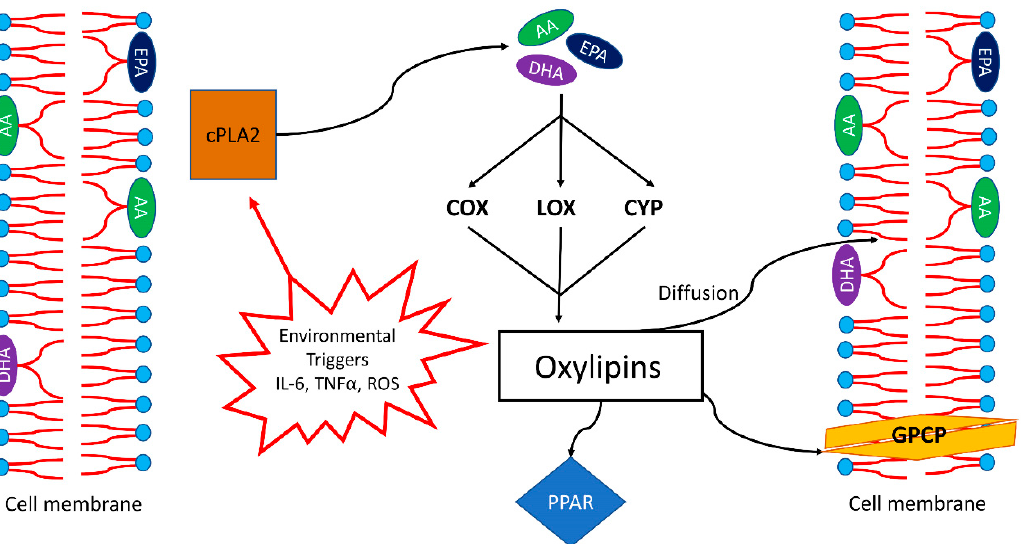
Figure 2. Formation of oxylipins from PUFAs in the membrane. In inflammation, reactive oxygen species (ROS) activate cytosolic phospholipase A2 (cPLA2), releasing PUFAs from the cell membrane. PUFAs are rapidly oxidized by COX, LOX, and CYP enzymes to form bioactive oxylipins. Oxylipins exert effects by diffusion, binding to membrane receptors (e.g., G-protein-coupled receptors (GPCP), and binding to peroxisome proliferator-activated receptors (PPARs) in the nucleus and cytosol. AA, arachidonic acid; EPA, eicosapentaenoic acid; DHA, docosahexaenoic acid; IL-6, interleukin 6; TNF α , tumor necrosis factor alpha; COX, cyclooxygenase; LOX, lipoxygenase; CYP, cytochrome P450. For details, see the main text.